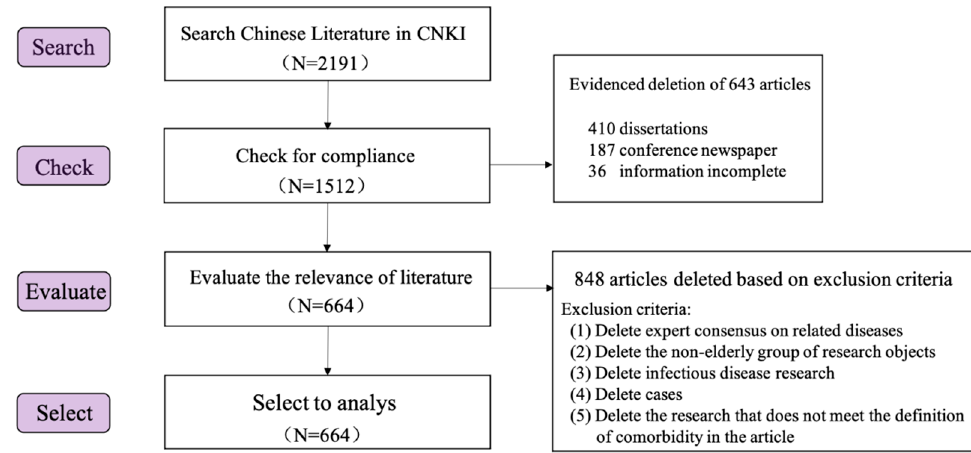
Figure 2. Domestic document retrieval